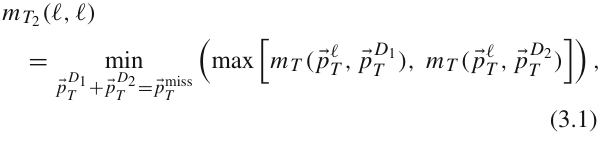
((cid:11), (cid:11)) > 150 GeV. We can see from the last able level, m T 2 row of Table 2. It reduces the cross sections of t ¯ t and W Wb of magnitude, respectively. As for t ¯ tV background and sig-